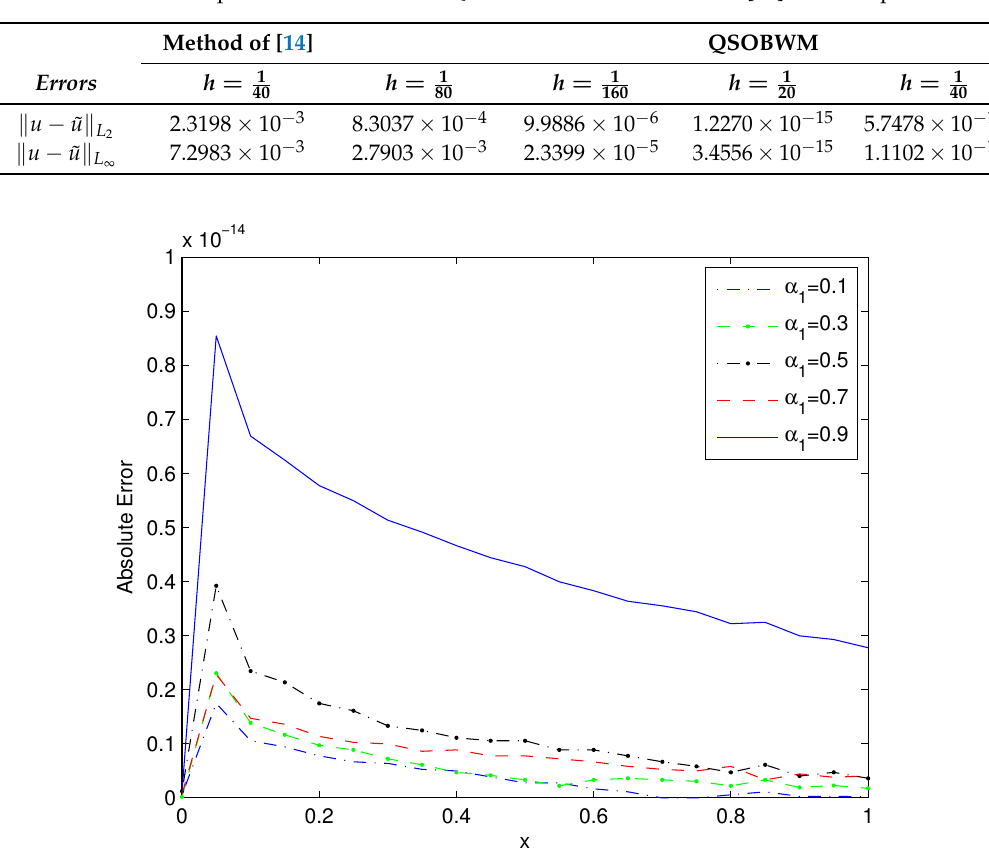
Figure 2. Absolute errors of Example 2 for QSOBWM with α 1 =